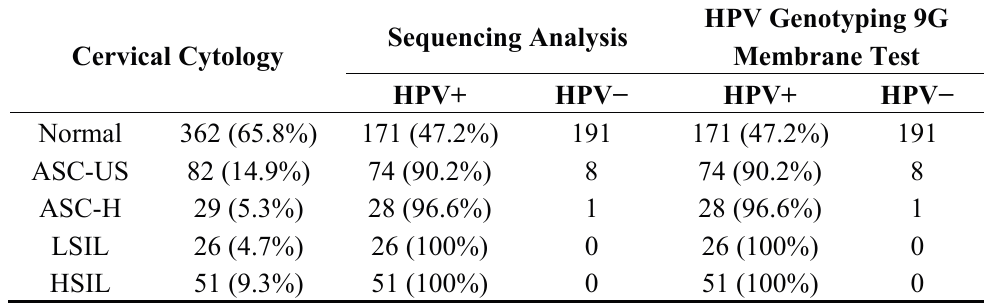
Table 2. Comparison of the results of HPV genotyping by cervical cytology with the results of the sequencing analysis and the HPV genotyping 9G membrane test (550 clinical samples).